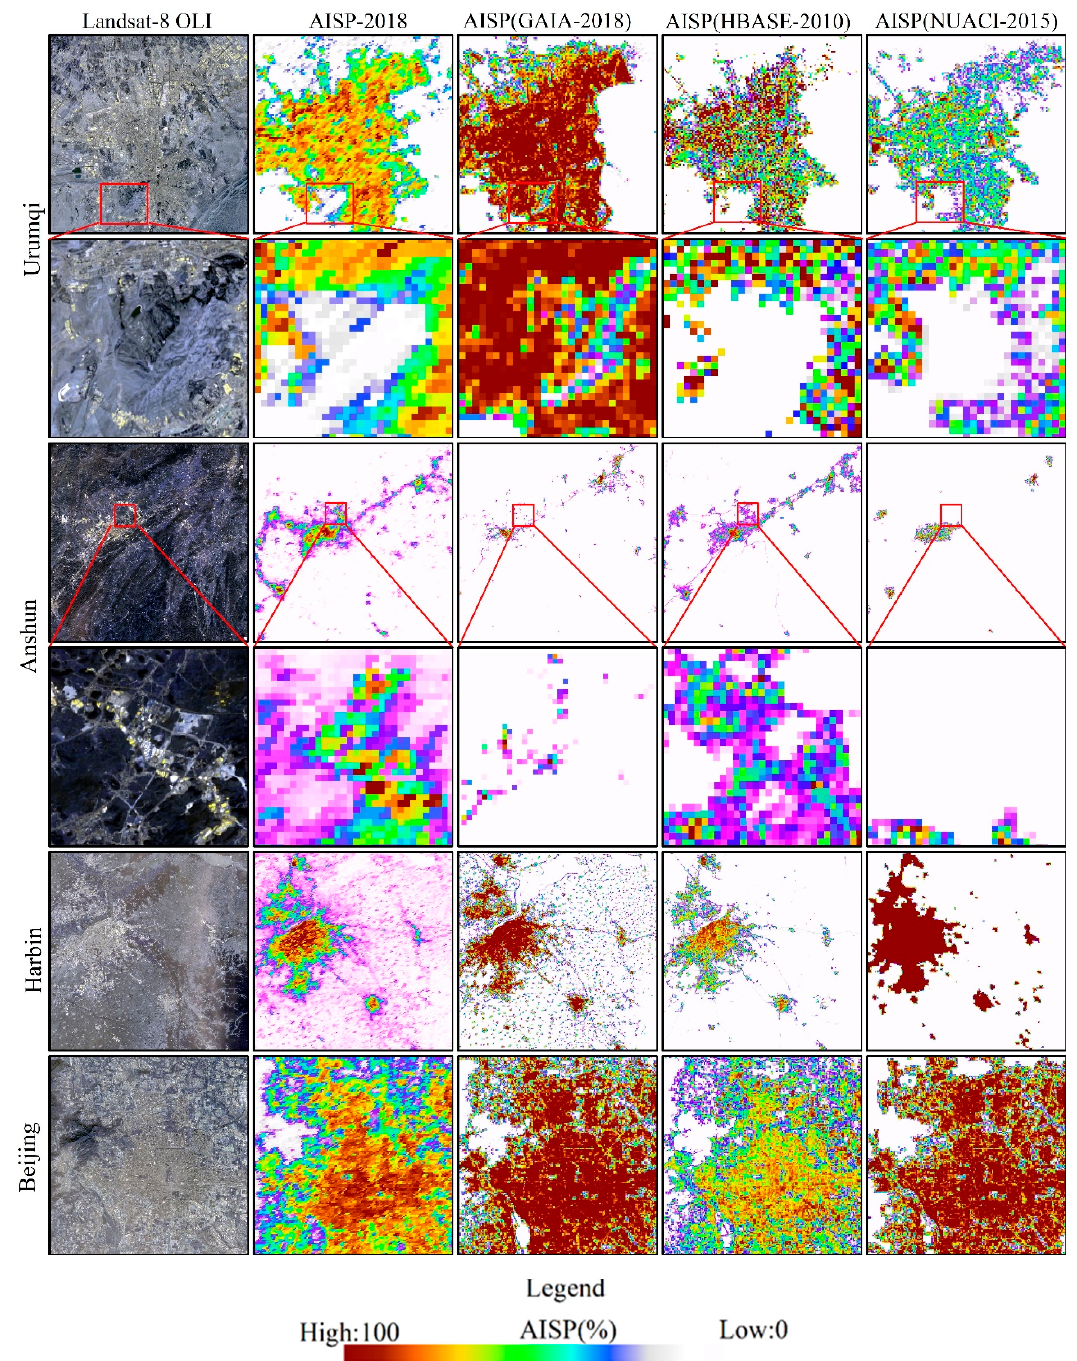
Figure 8. Comparison of artificial impervious surface amongst four products over typical regions. To evaluate the performance of our results quantitatively and compare with other global impervious surface datasets, four typical regions were selected. For each verifica- tion region, 1000–2500 samples were randomly collected for evaluation. For other da- tasets, they were converted into impervious surface percentage data with the same spatial resolution. The reference data are obtained based on Landsat 8 images. As shown in Table 6, compared with HBASE and NUACI products, our proposed method achieved better performance. While compared with GAIA product, our method obtained lower accuracy in some big and developed cities such as Harbin and Beijing but obtained significant im- provement for some cities such as Urumqi and Anshun, which indicates that our pro- posed method has better adaptability in some areas with less vegetation overage and dif- ficult data acquisition.